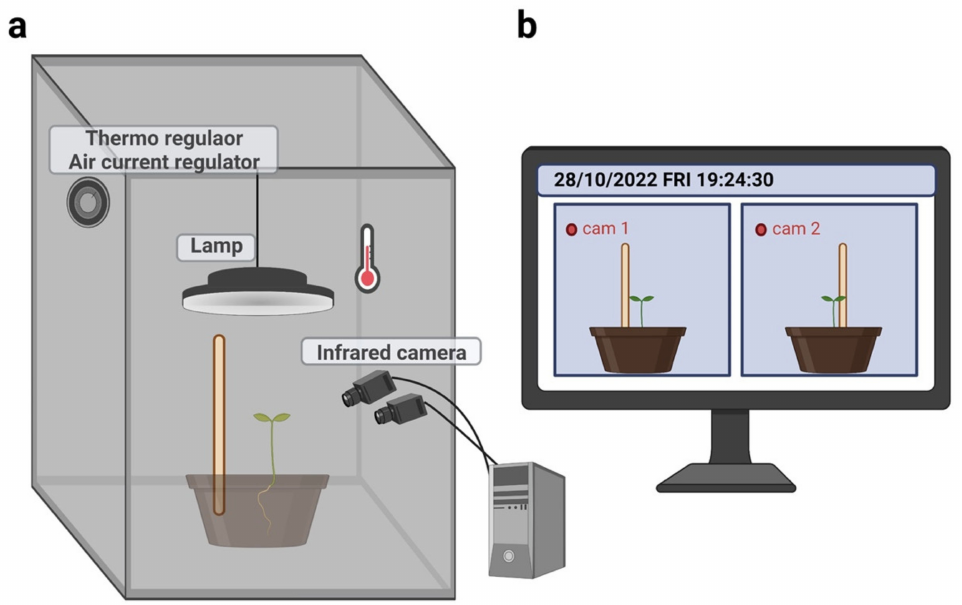
Figure 4. Graphical illustration of ( a ) experimental setup and ( b ) demonstration of how plants were captured by the infrared